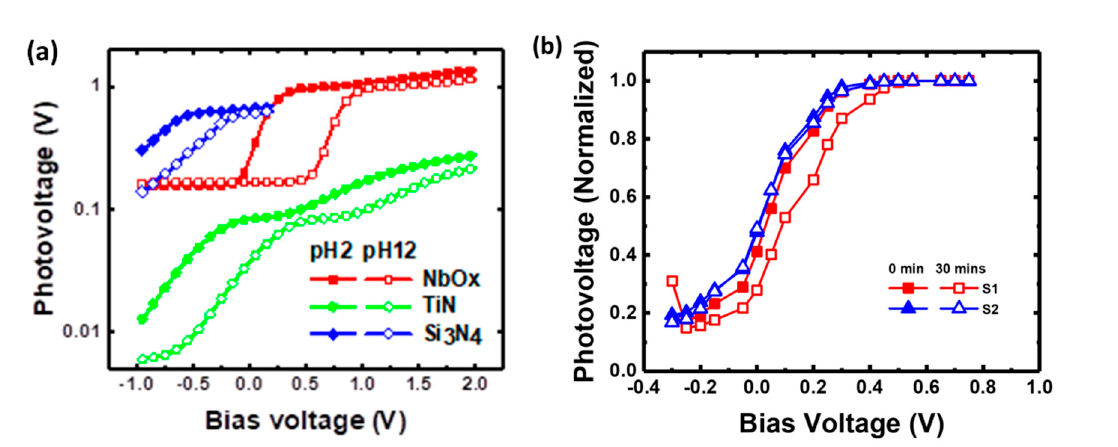
Figure 3. ( a ) photovoltage versus bias voltage curves of 3 different device structure. ( b ) photocurrent of C3A cells acidification behavior on Si 3 N 4 membrane after seeding 2.5 × 10 4 on each sample for 48